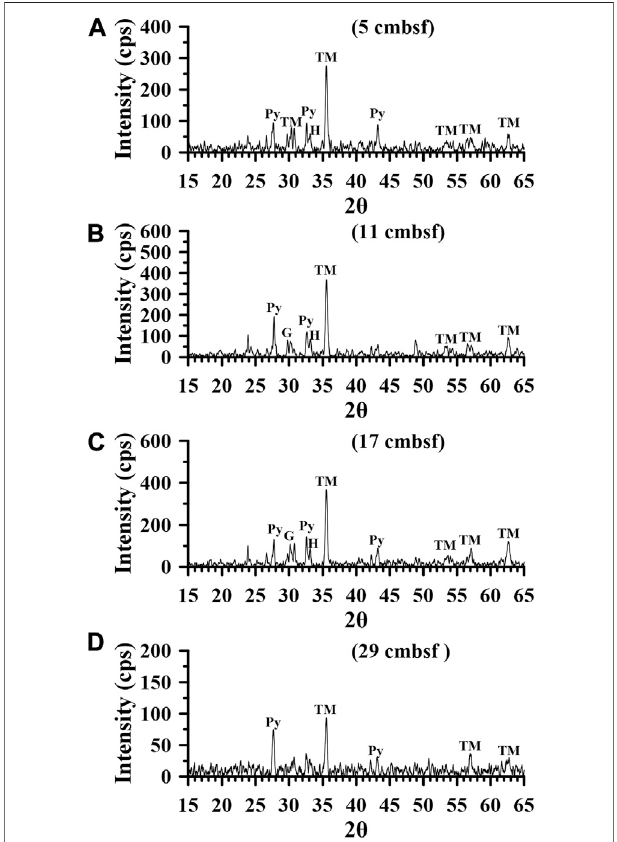
FIGURE 11 | (A – D) X-ray diffraction spectra for magnetic minerals extracted from different sediment intervals of relict seep site: SSD-45/Stn-11/ GC-02. TM, titanomagnetite; H, hematite; Py, pyrite; and G, greigite.